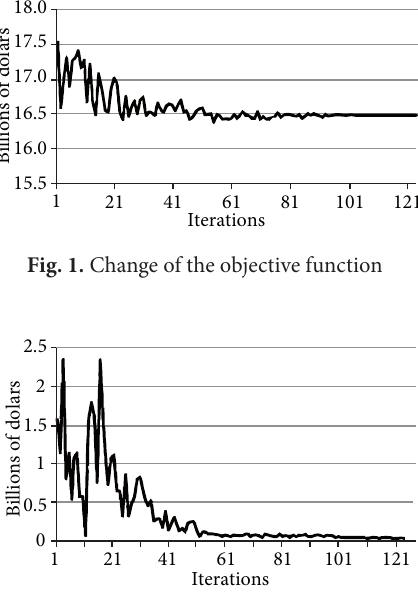
Fig. 3. Change of confidence interval Fig. 4. Change of Hotelling